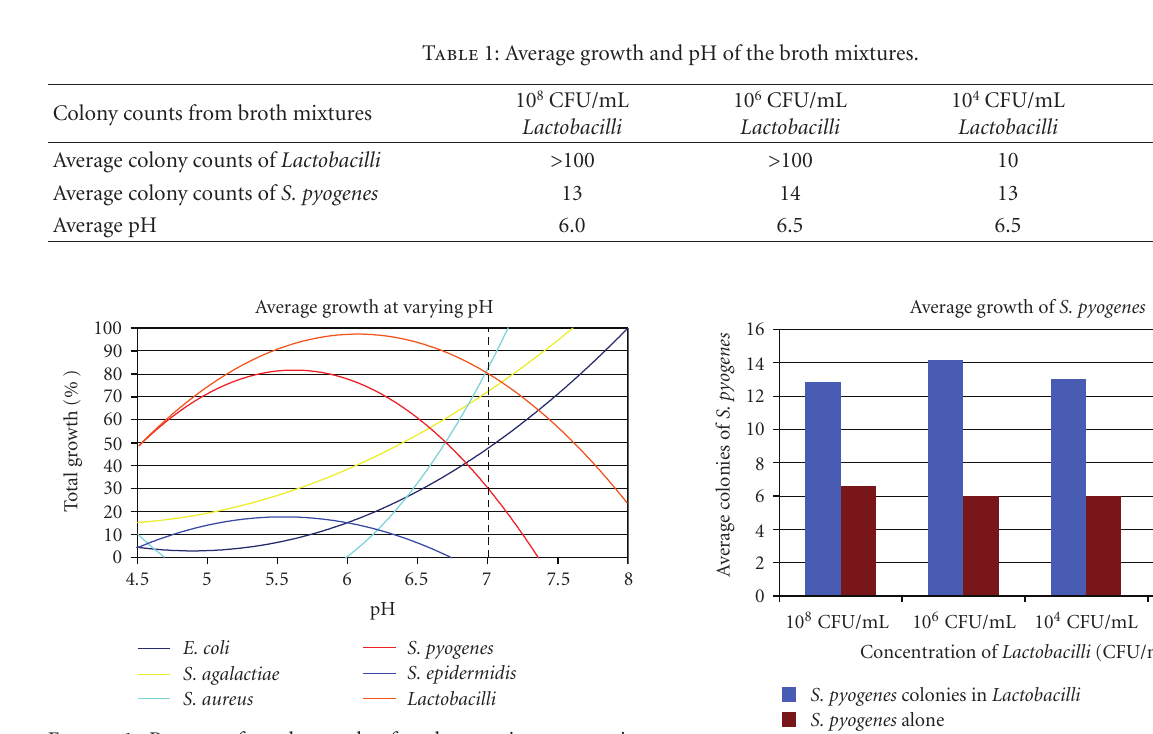
Figure 1: Percent of total growth of each organism comparing growth with Lactobacilli to growth without Lactobacilli . These data were taken from the results of this study.